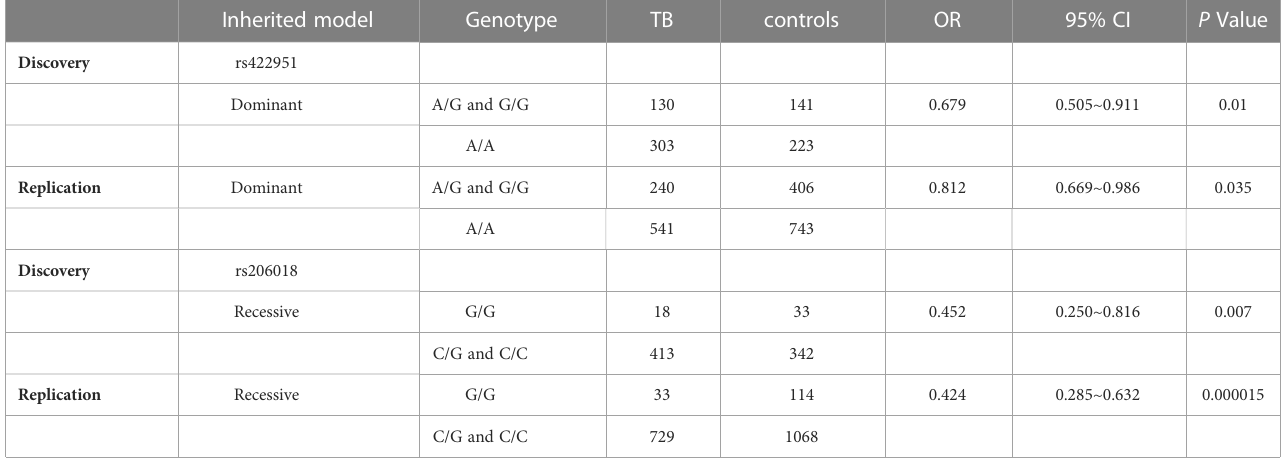
TABLE 2 Distribution and frequencies of Notch4 genotype with different genetic models in tuberculosis patients and